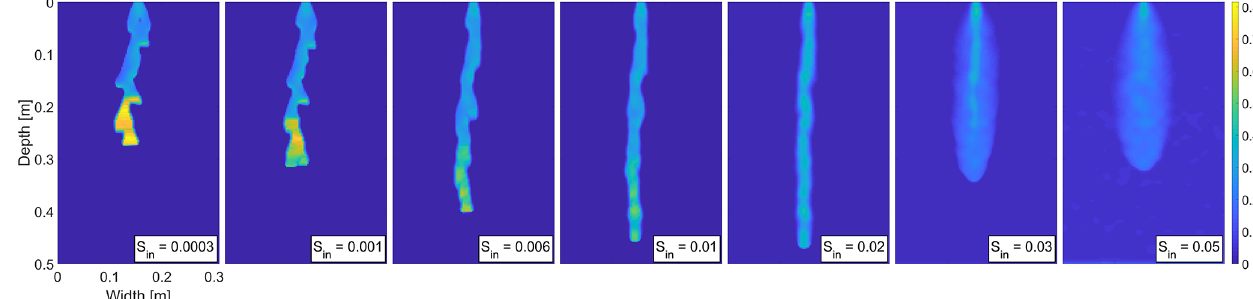
Figure A8. Snapshot of the saturation field at 25min for seven different values of the initial saturation for the distribution which satisfies κ max /κ min ≈ 3 . 90 (the distribution in Fig. A2g). Saturation values are color coded according to the color bar on the right.